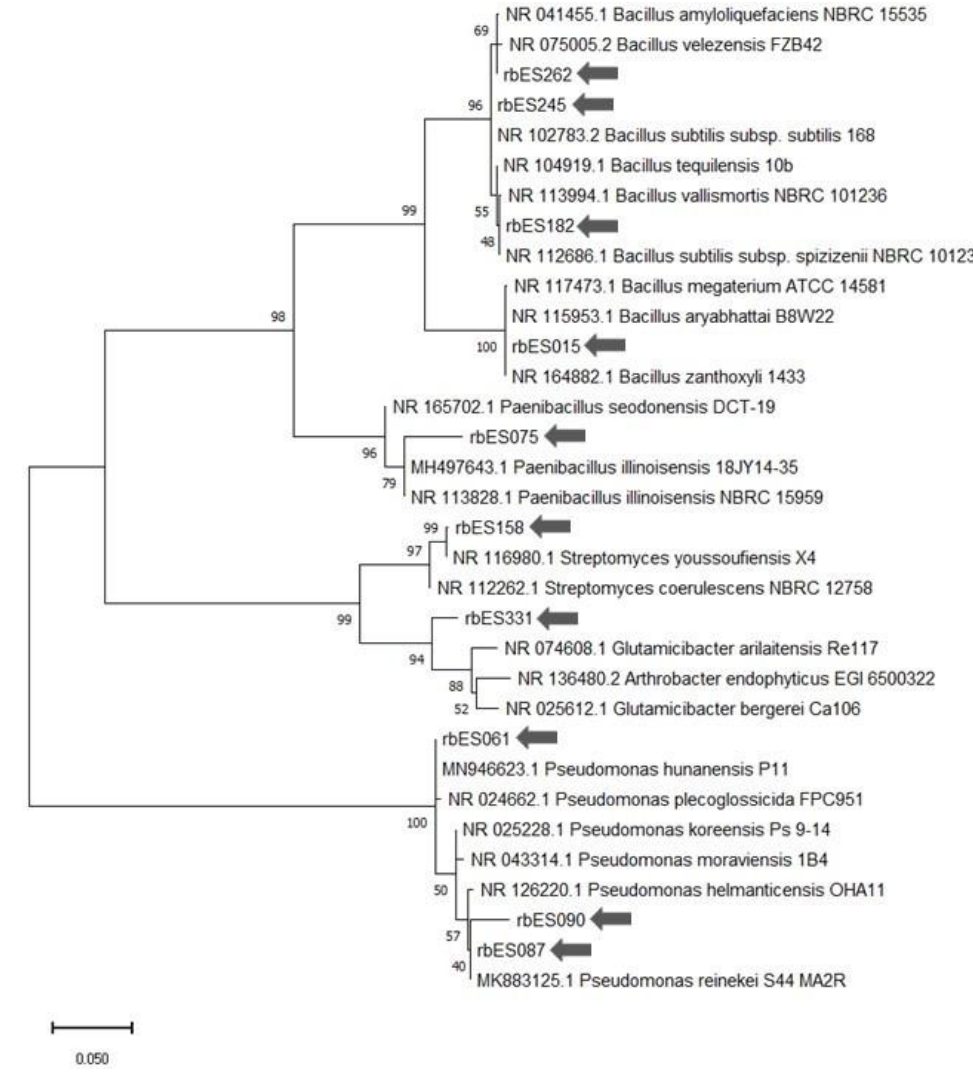
Figure 2. Maximum-Likelihood tree of partially sequenced 16S rRNA gene. Arrows indicate strains described in this work. Values above nodes are bootstrap values obtained from 1000 replicates.